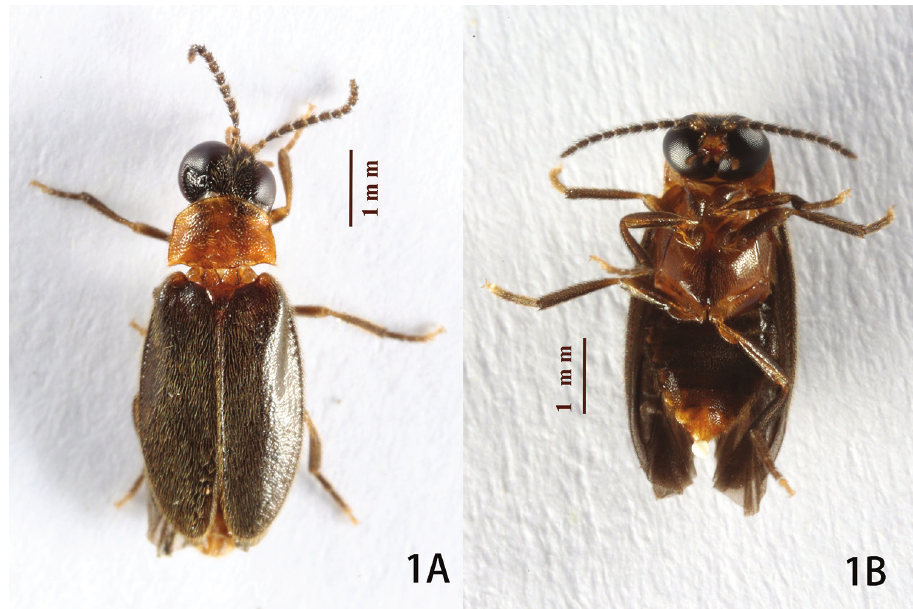
Figure 1. Habitus of holotype of Oculogryphus chenghoiyanae sp. n., dorsal ( A ) and ventral ( B ) aspects.